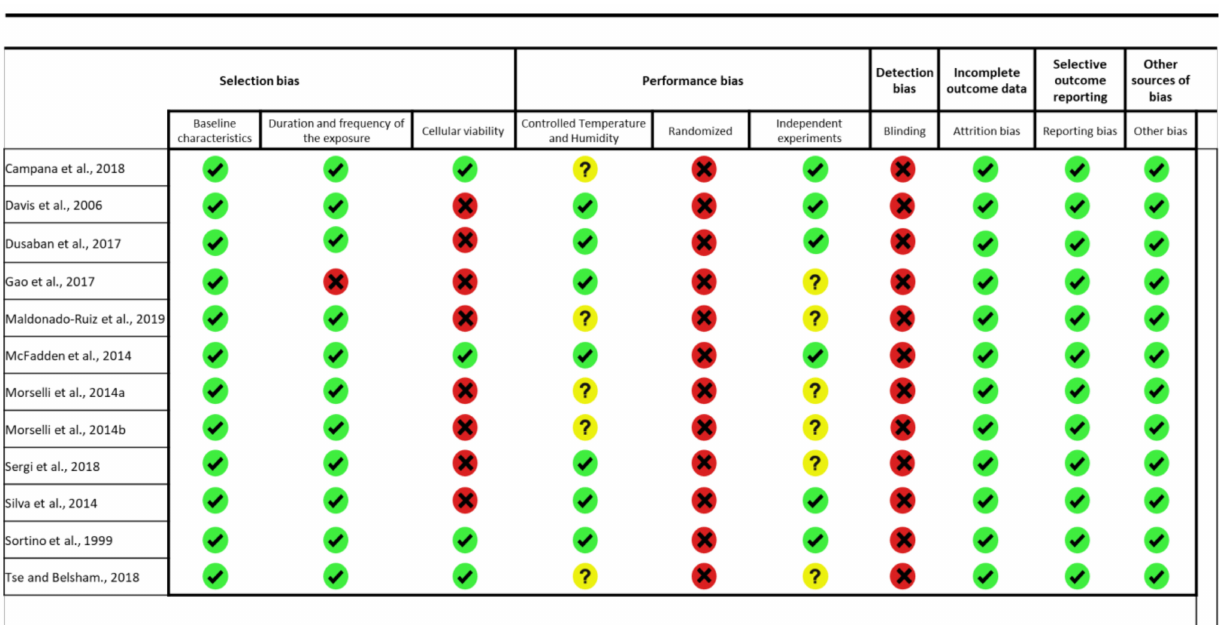
Figure 2. Risk of bias (RoB) from in vitro studies. Summary of the authors’ judgments concerning risks from included in vitro studies.